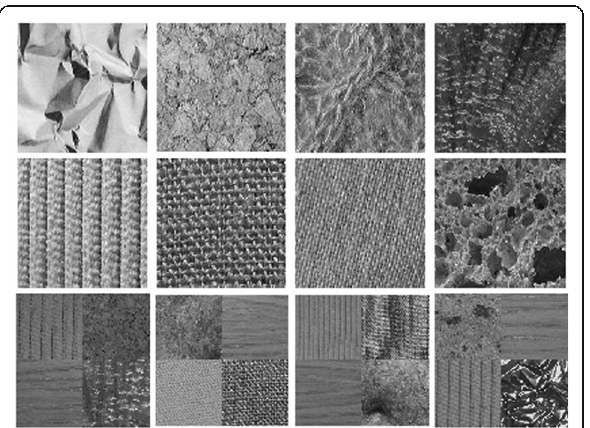
Fig. 5 Texture samples from Brodatz album